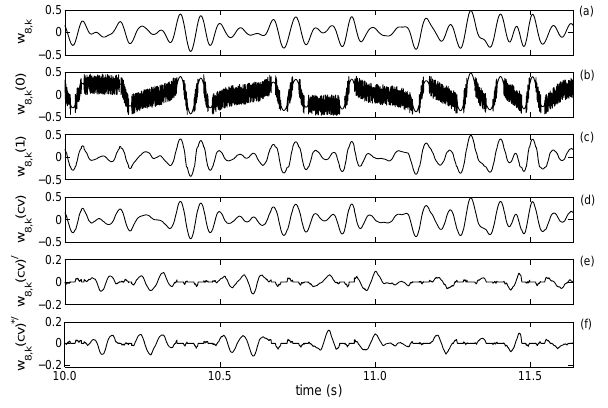
Fig. 2. Illustration of the surrogate generating algorithm for u 1 with ρ = 0 . 5 just showing MODWT scale j = 8. The w j = 8 ,k = 1 : N at this scale from the original MODWT are shown in (a) , while (b) shows the fixed coefficients together with randomised values added to a cubic Hermitian polynomial that is used to interpolate between fixed values. The coefficients after one full iteration of the IAAFT algorithm has been applied to the coefficients in (b) are shown in (c) and the results after convergence (indicated by cv) are in (d) . The difference between (a) and (d) is indicated by the prime and is given in (e) , while (f) shows the differences for another realization of (b) after convergence of the IAAFT